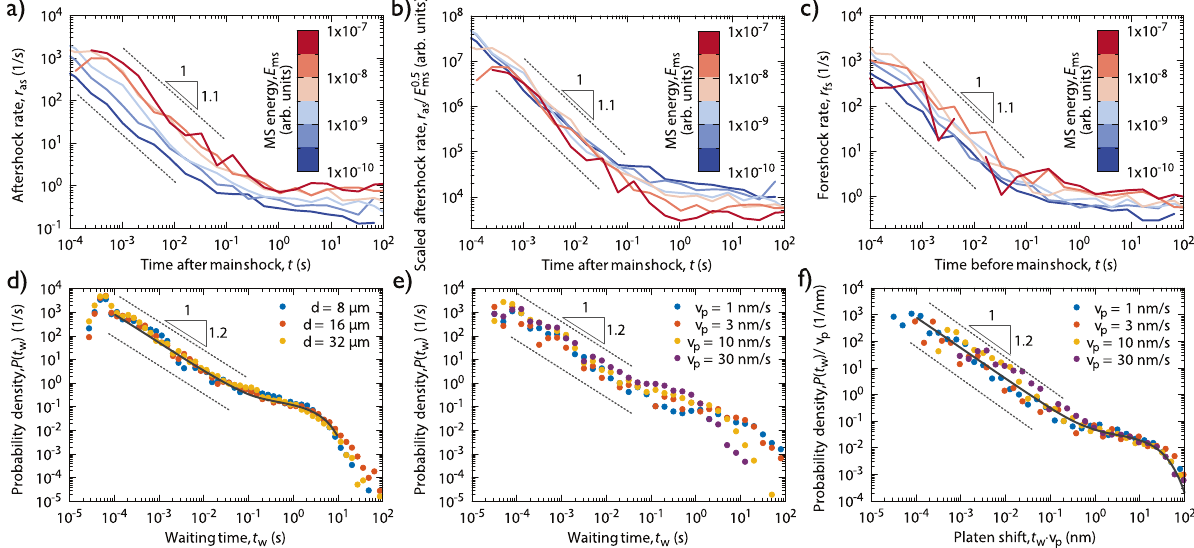
Fig. 3 Temporal statistical analyses of AE events. a The rate of aftershocks r as after a main shock with an energy given by the colour for d = 32 μ m pillars (Omori law). b Curves of panel a) divided with the square root of the main shock energy E ms (aftershock productivity law). c Rate of foreshocks r fs before a main shock of energy given by the colours for d = 32 μ m pillars (inverse Omori law). d PDF P ( t w ) of waiting times t w between subsequent AE events for pillars of various sizes. e P ( t w ) for d = 8 μ m pillars and different platen speeds v p . f P ( t w ) re-scaled with the platen velocity v p . Note that the minimum t w of 20 μ s, i.e., the minimum time between two subsequent AE events, is de fi ned as one of the AE event individualization parameters (see due to the onset of new sequences. In accordance with the productivity law the rate is larger for larger main shocks and collapse can be obtained by re-scaling the rate with E 0 : 5 ms (Fig. 3b), yielding α = 0.75. As a further proof of equivalence, Fig. 3c plots the correspondent of the inverse Omori law describing the power-law increase in the rate of foreshocks r fs before a main shock 19 . (Supplementary Fig. 4 shows the corresponding fi gures for smaller pillars.) Previously, a similar analysis of AE on hexagonal ice at the bulk scale also showed more abundant triggering after large events, but the scale-free characteristics presented here were not possible to obtain, likely because of the relatively high level of noise 20 . It is also noted, that the difference between the foreshock and aftershock rates is signi fi cantly smaller compared to that of earthquakes. It is speculated that the difference is caused by the ambiguity in the determination of the main shock due to the noise present in the AE energy measurement.